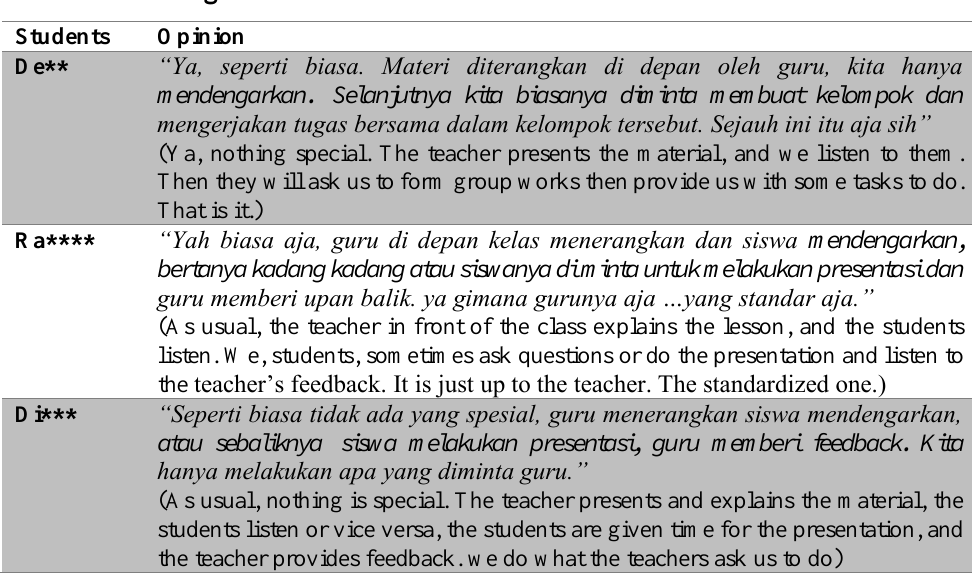
Table 3. Knowledge transmission